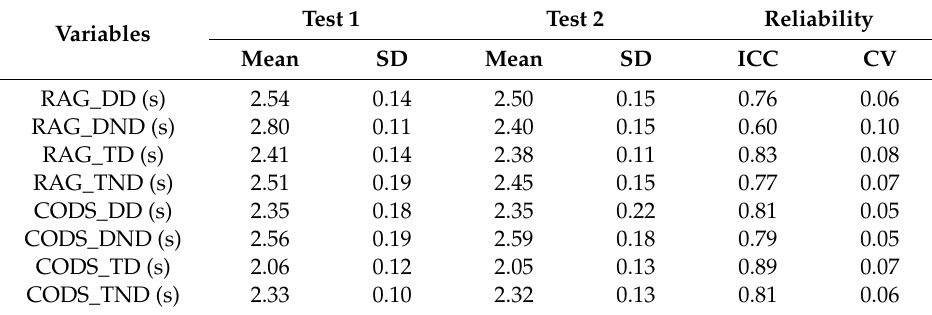
Table 2. Test–retest reliability results (n =